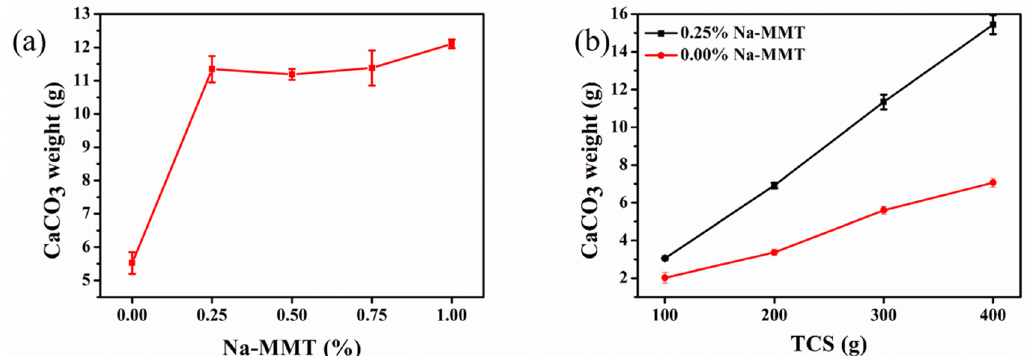
Figure 5. The total mass of CaCO 3 precipitates with different Na-MMT concentrations ( a ) and with TCS quantities with and without Na-MMT ( b ).